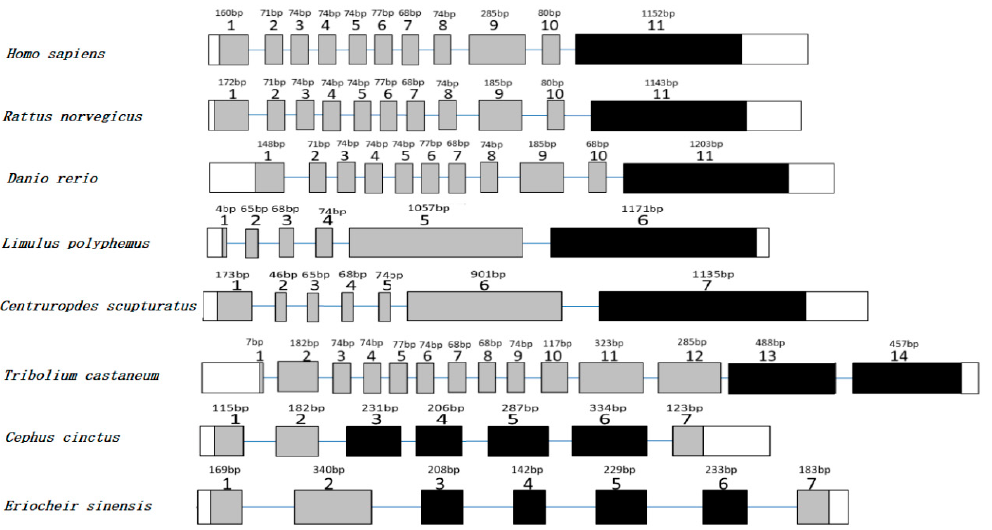
Figure 2. Schematic diagram of EsLHR gene structure as compared with various species. The gray and black boxes represent exons, in which the black indicates the exons coding the seven-transmembrane domain. Arabic numerals mark the exon positions. The length of each exon was indicated as base pairs (bp).